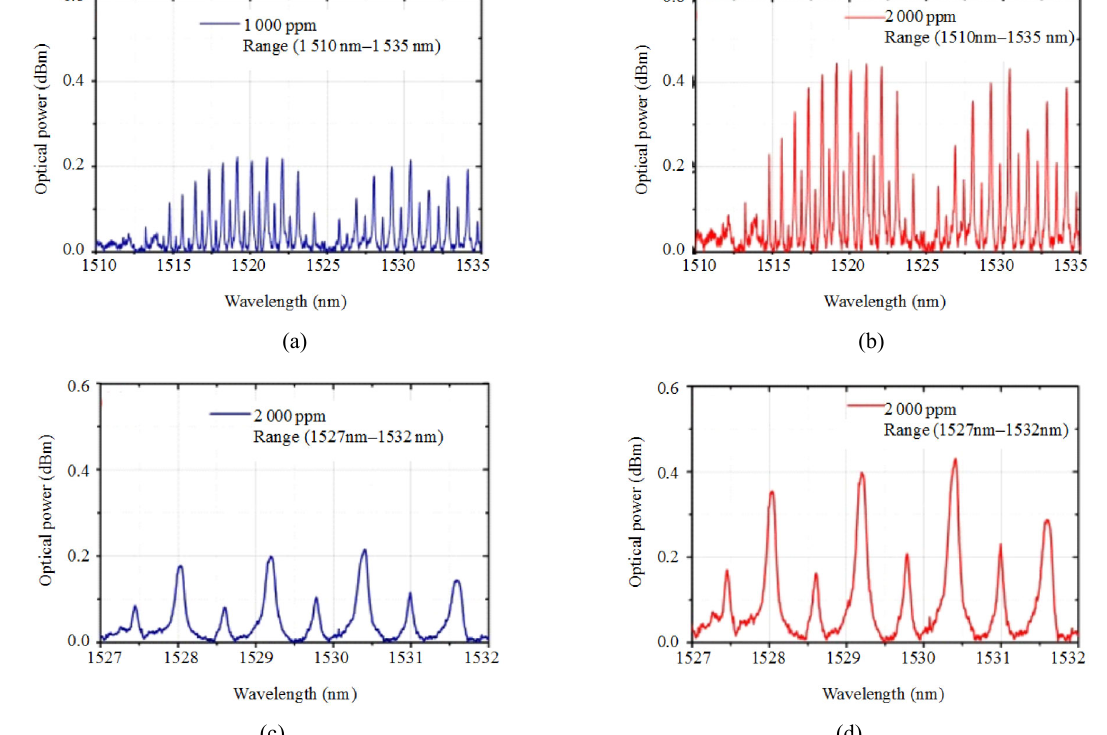
Fig. 7 Comparison of C 2 H 2 of different concentrations after data process: (a) 1 000 ppm C 2 H 2 (1 510 nm – 1 535 nm), (b) 2 000